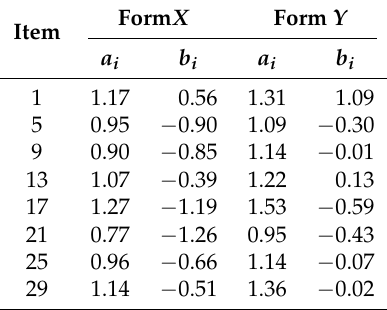
Table 6. 2PL Linking Study: Item Parameters Taken from Meyer and Zhou [144].